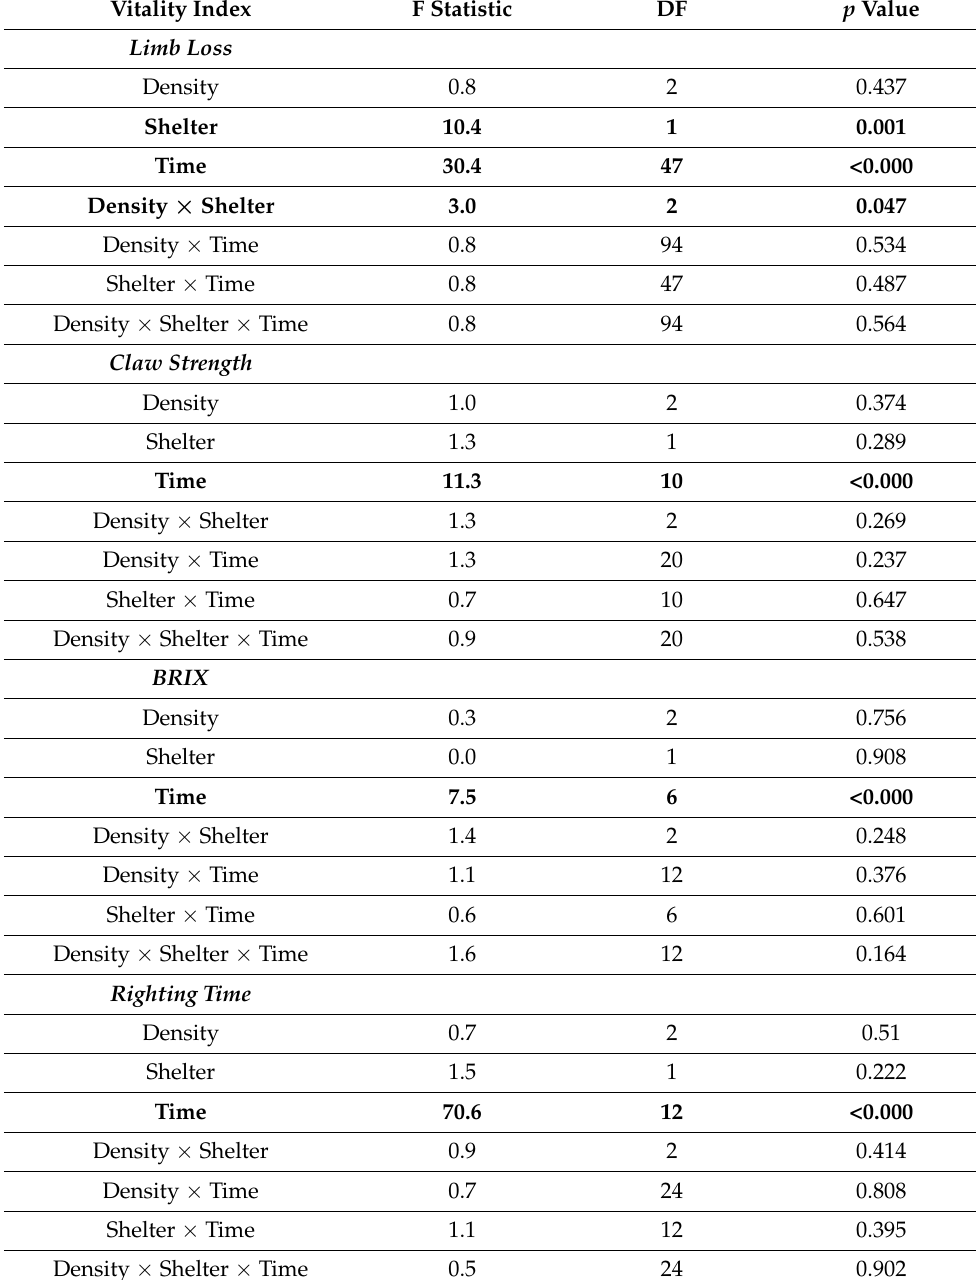
Table 3. Statistical analysis of the vitality indices using full factorial model with main effects for time, shelter, density and their various interactions. Using a non-parametric analysis for longitudinal data (nparLD), ANOVA-type F (F statistic) and p values and the degrees of freedom (DF) are given for each factor and interactions. Significant results ( p < 0.05) are in